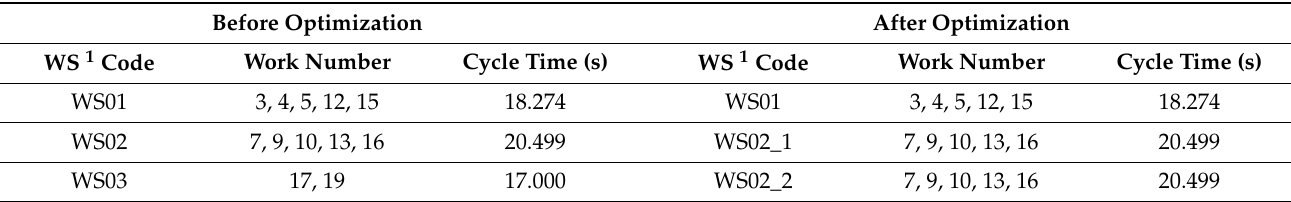
Table 6. Comparison of the layouts before and after